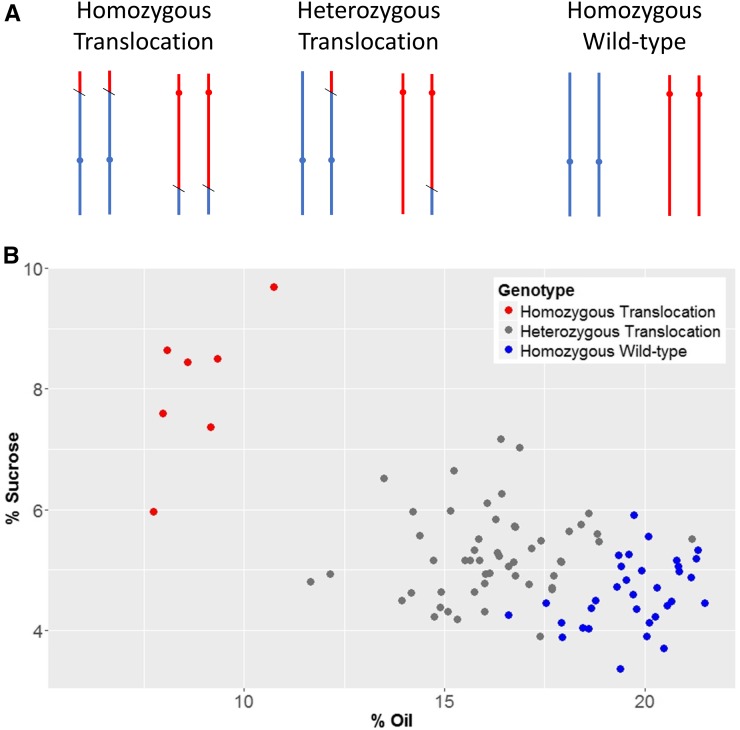
The association between the reciprocal translocation and seed sucrose and oil content. (A) Chromosome 8 (blue) and chromosome 13 (red) in homozygous translocation, heterozygous translocation, and homozygous wild-type states are shown. (B) The sucrose and oil seed composition in which each data point represents an individual in the BC1F2 population and colored by genotype class.